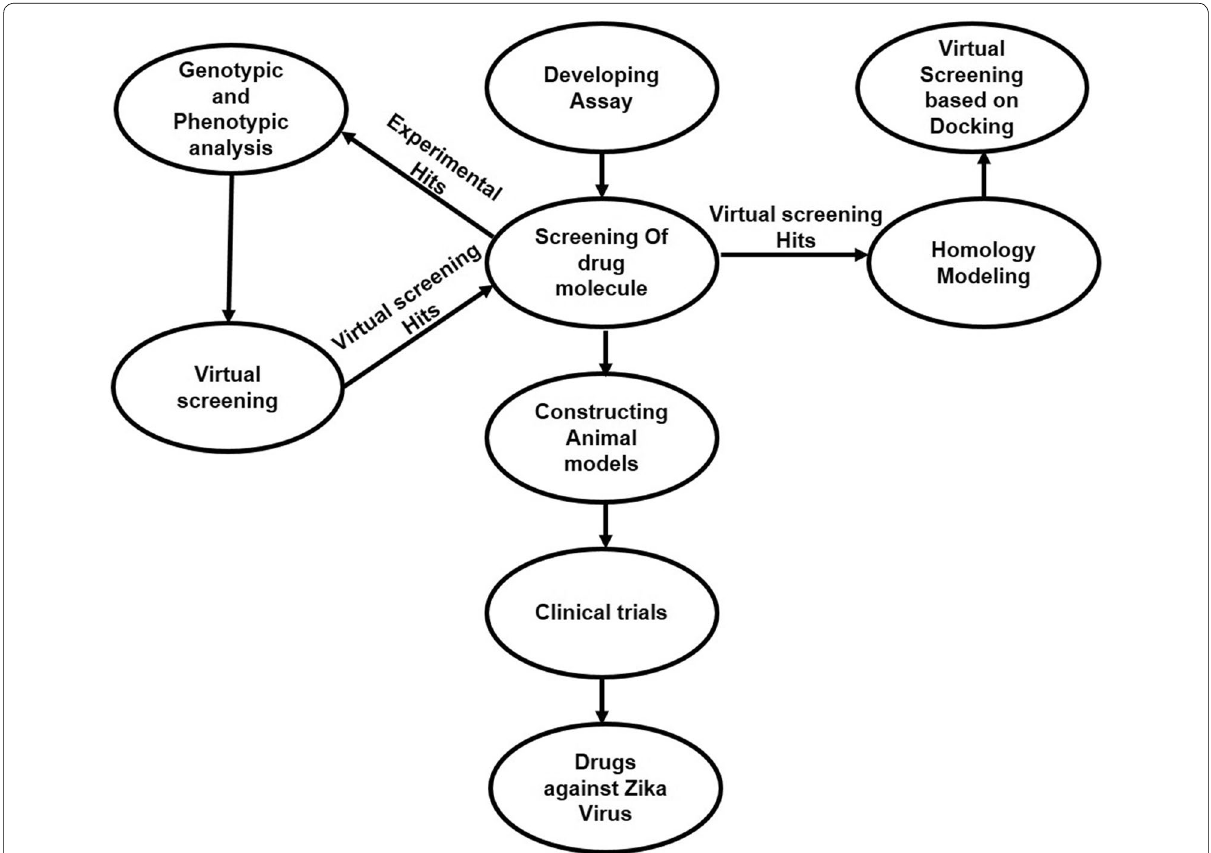
Fig. 7 Proposed workflow for drug development against